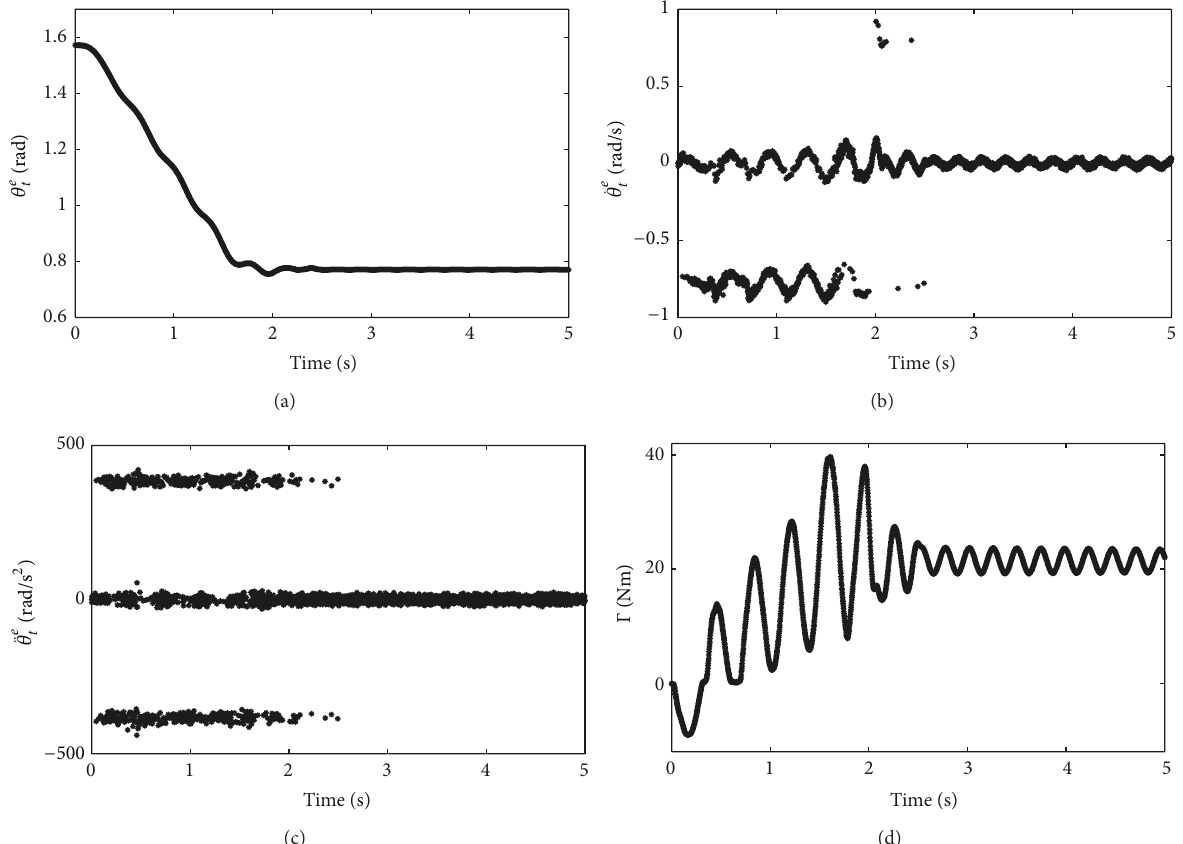
Figure 3: Example of the signals involved in the identification algorithm to discuss (a) estimation of the tip position (𝜃 𝑒 𝑡 ) , (b) first-order numerical time differentiation of the estimation of the tip position ( ̈𝜃 𝑒 ) , and (d) coupling torque (Γ) . the tip position ( 𝑡